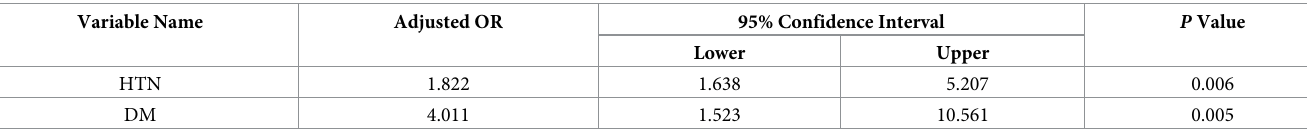
Table 3. Binary logistic regression for chronic disease and mortality rate.